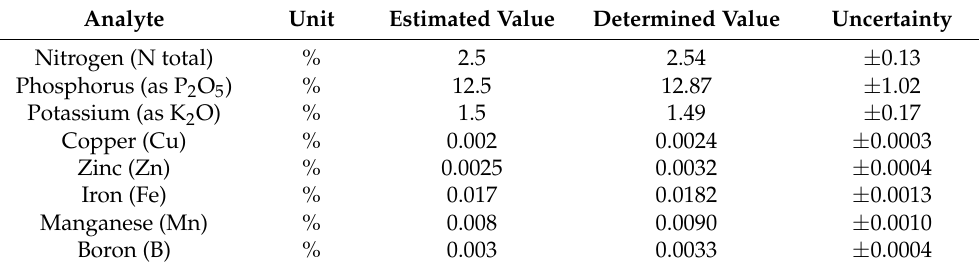
Table 4. Composition of the prepared foliar fertilizer, NanoFert D, estimated value (according to receipt) and determined